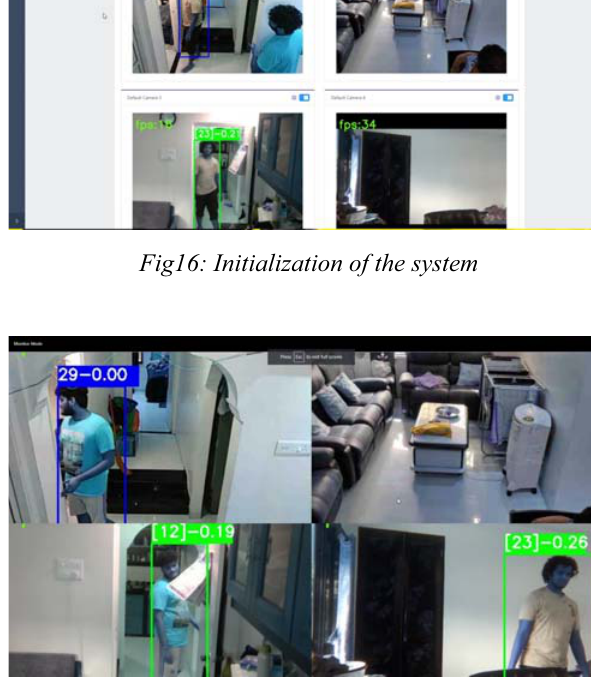
Fig14: Benchmark of our system